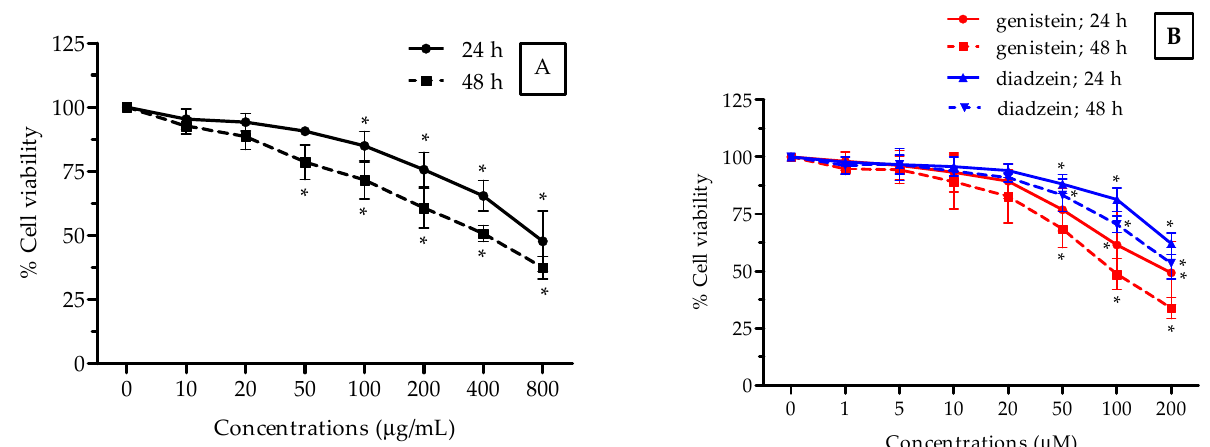
Figure 2. Cytotoxicity activity of the ethanolic isoflavone extracts from Thua-nao ( A ) and genistein and diadzein ( B ) at various concentrations in HEK293 cells for 24 h and 48 h of incubation. All results are presented as the mean ( n = 3) ± SD. * p < 0.05 compared to the nontreatment control in each incubation time.